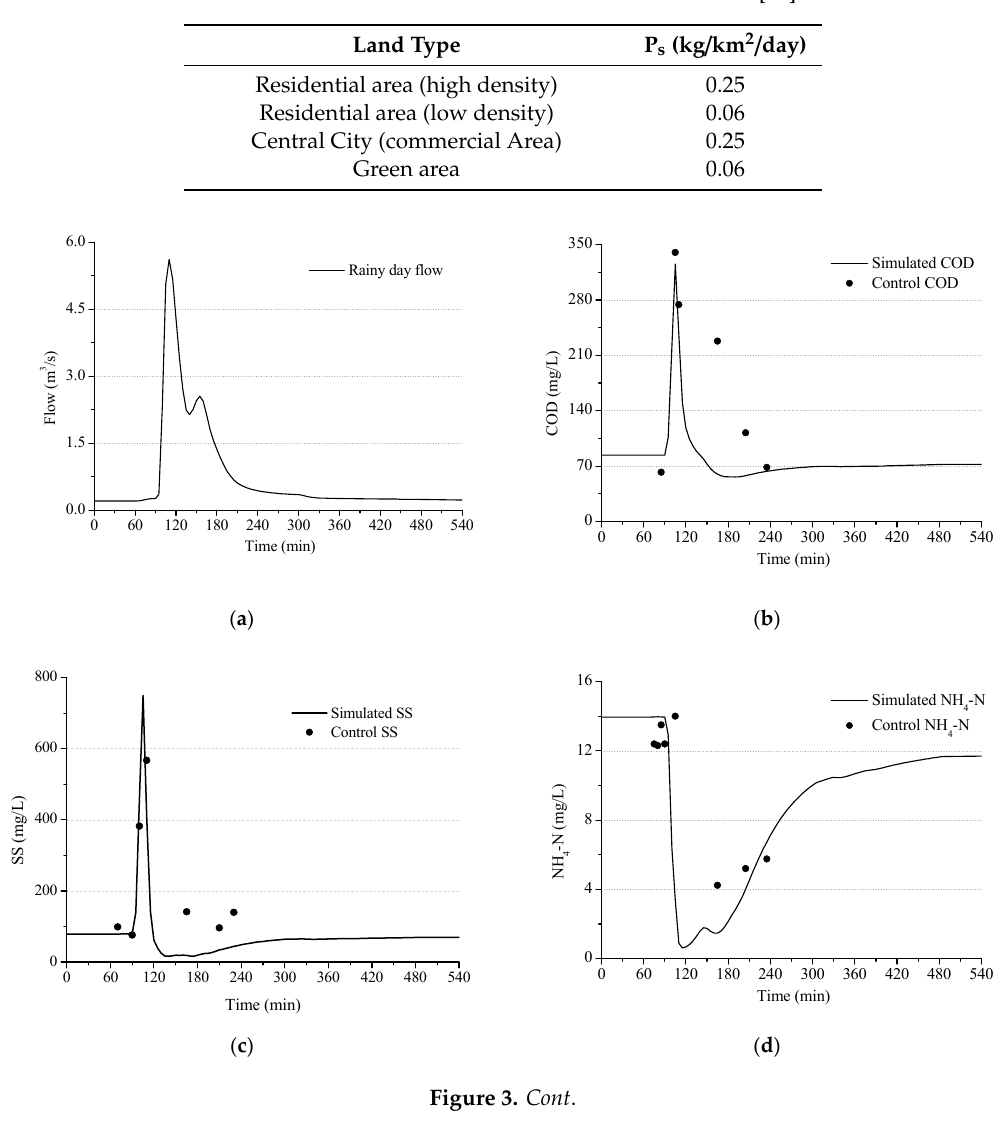
Table 3. Reference value of sediment accumulation rate [24].